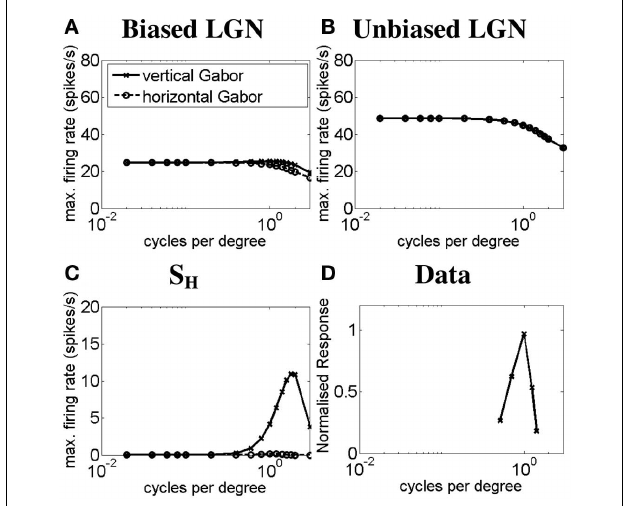
FIGURE 6 | Simulated orientation tuning for simple cell, S1 in response to a bar 0.5˚ in length. The OT curves are shown for (A) the orientation-biased LGN field with a weak surround driving the simple cell, (B) the unoriented LGN field with a stronger surround that disynaptically inhibits the simple cell, (C) the feed-forward input rate received by the simple cell, and (D) the simple cell S1. In (A–D) the y -axis represents the maximum firing rate in spikes/seconds, and the x -axis represents the bar length in degrees.